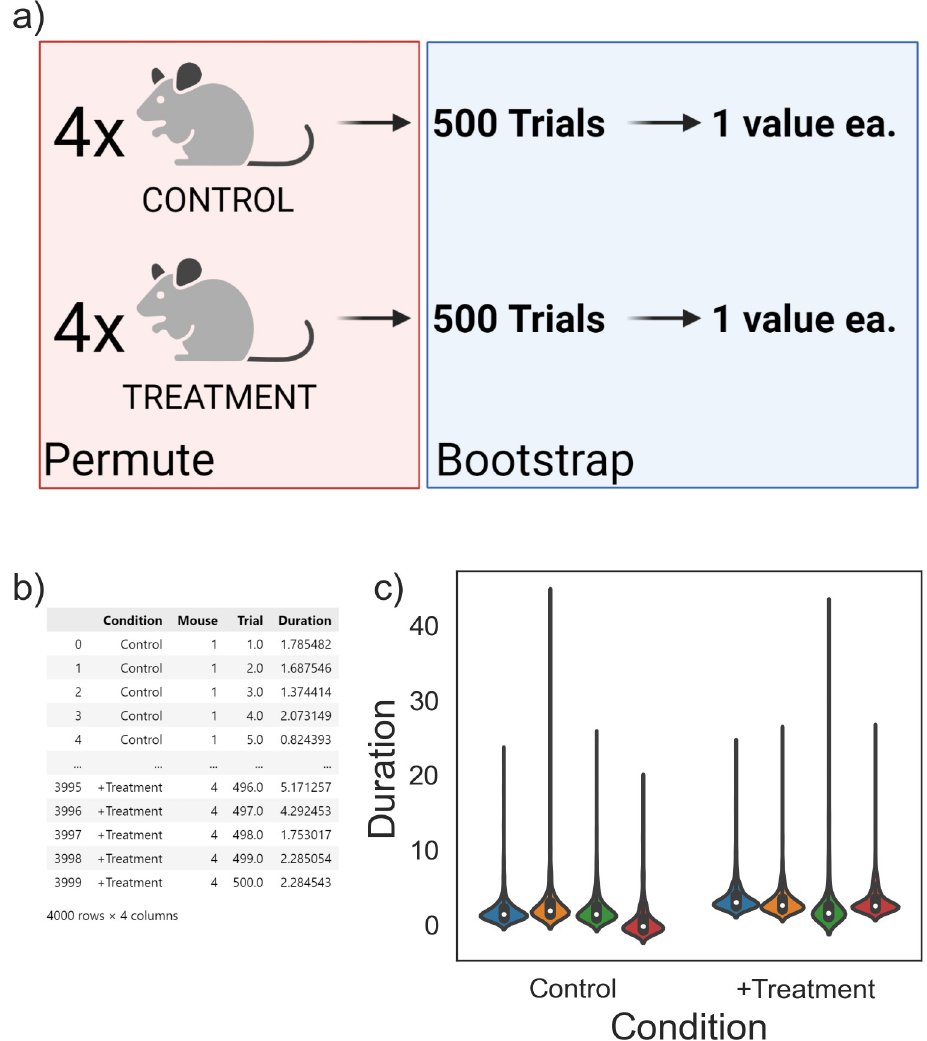
Fig 5. Using hierarchical randomization to analyze a mouse behavioral study. (A) Simulated data corresponding to an experiment with two treatments, four mice each, 500 trials each. (B) A table of raw data collected in this study. By organizing the input data into columns corresponding to the experimental design, Hierarch can automatically infer the correct resampling plan for the dataset. (C) Violin plots illustrating the skewed nature of the dataset. p = 0.037, hierarchical randomization, p = 0.038, Student’s t test. Panel (A) was created using BioRender.com.